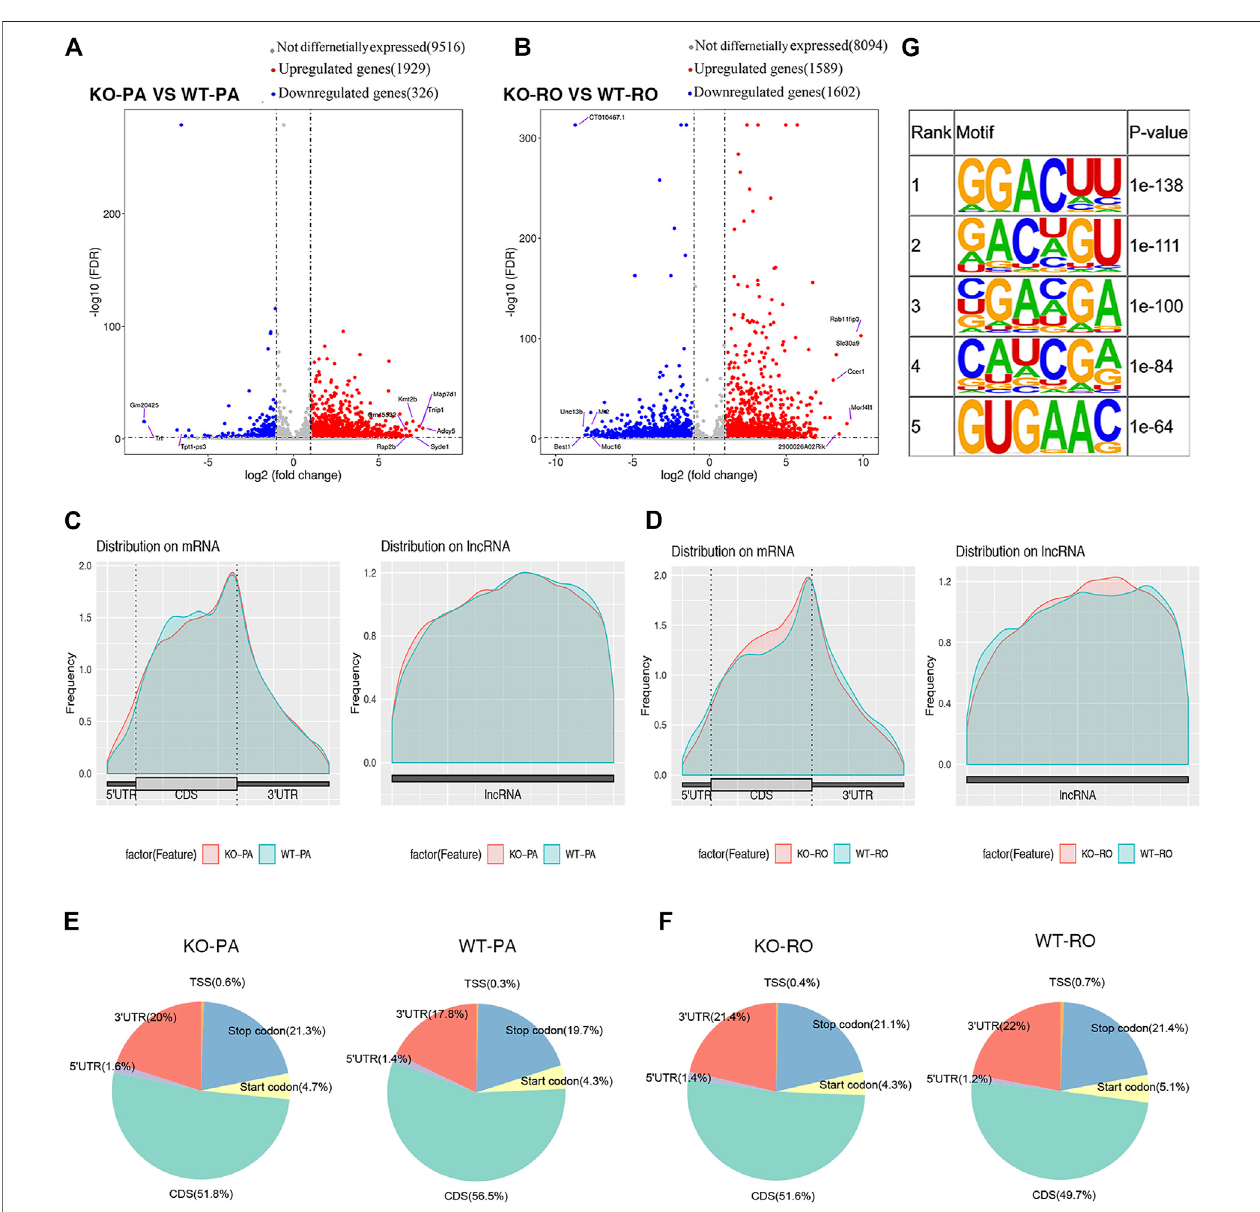
FIGURE 2 | Volcano plot showing differential methylation peaks between WT PA and Alkbh5-KO PA (A) . Volcano plot showing differential methylation peaks between WT RO and Alkbh5 -KO RO (B) . m6A peaks were most enriched in the coding sequence near the stop codon on mRNA and the distribution on lncRNA in PA (C) . m6A peaks were most enriched in the coding sequence near the stop codon on mRNA and the distribution on lncRNA in RO (D) . Distribution of different regions in Alkbh5 -KO and WT PA (E) . Distribution of different regions in Alkbh5 -KO and WT RO (F) . Top fi ve consensus sequence motifs enriched in m6A peaks identi fi ed from Alkbh5-KO PA (G)